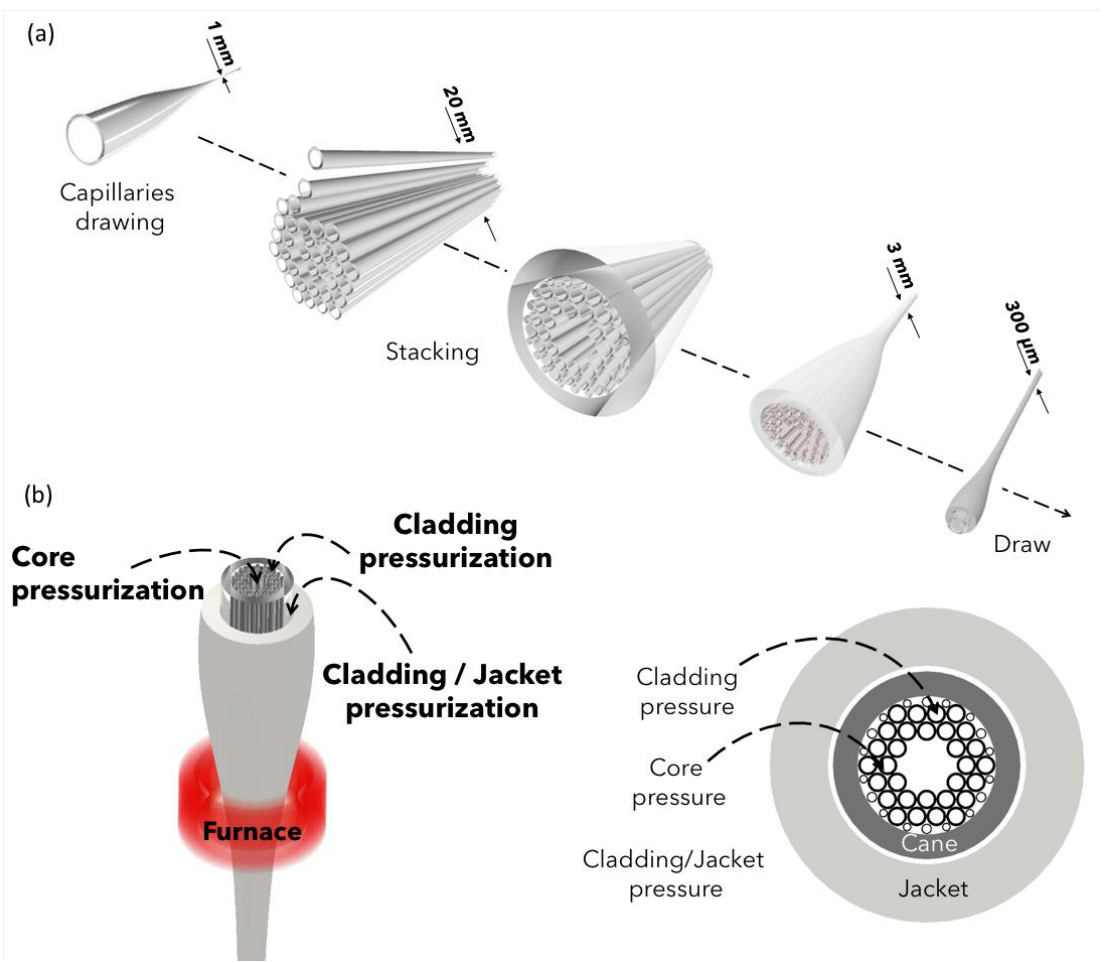
Figure 3. ( a ) Schematic of the HCPCF fabrication process highlighting; ( b ) the structuration of glass with